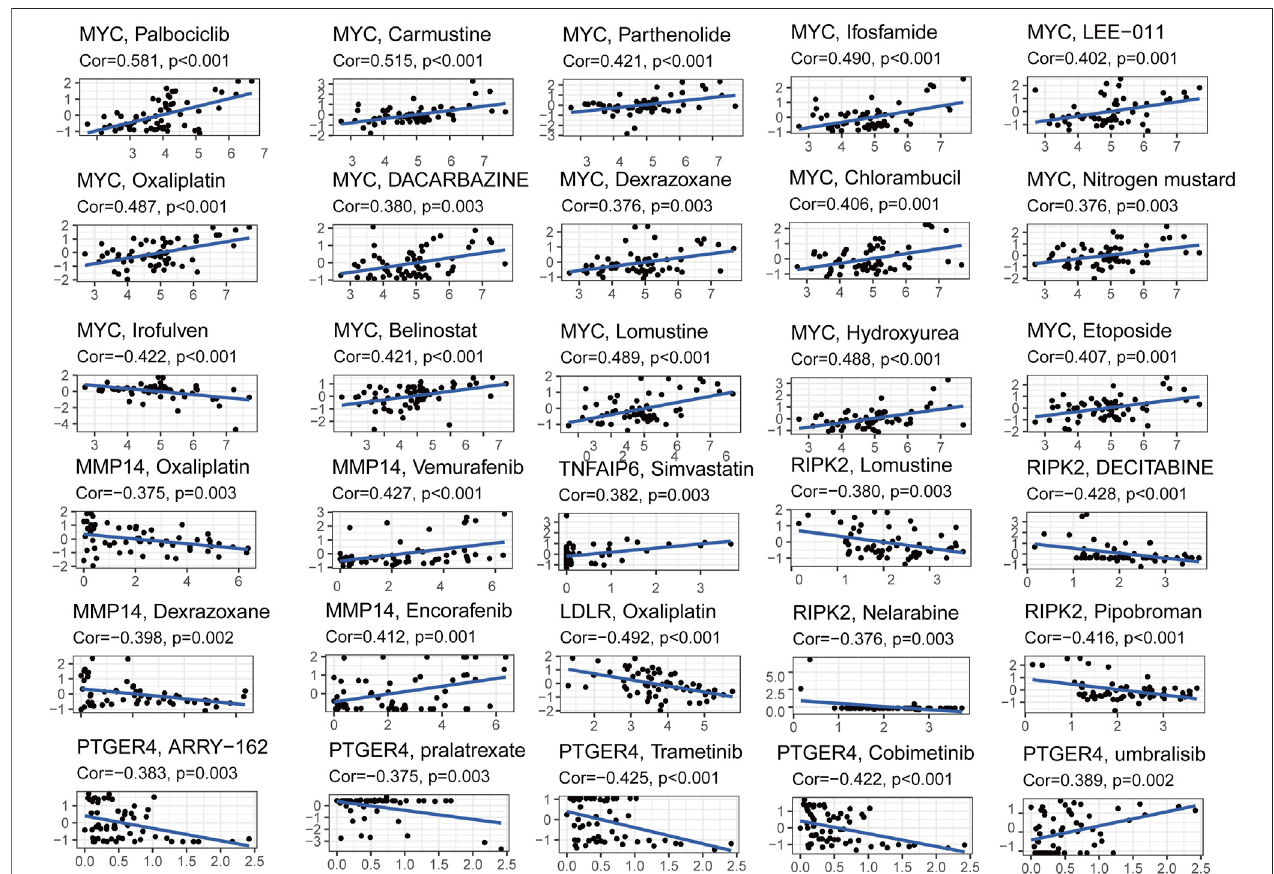
FIGURE 9 | Scatter plots of correlation analysis between chemotherapeutic drugs sensitivity and expression of signature genes.